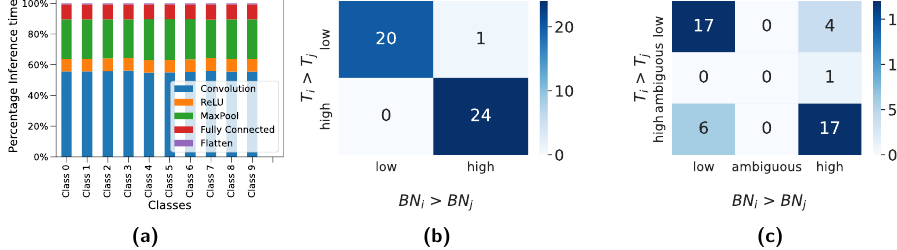
Figure 6: (a) Percentage of time taken by each layer type in single inference for all 10 classes (b)First Maxpool Layer Timing correlation with Branch not taken instructions (c) Second Maxpool Layer Timing correlation with Branch not taken instructions assignment executions for input X and Y differ from each other, hence causing difference in the execution time of the MaxPool operation and the overall inference time of an